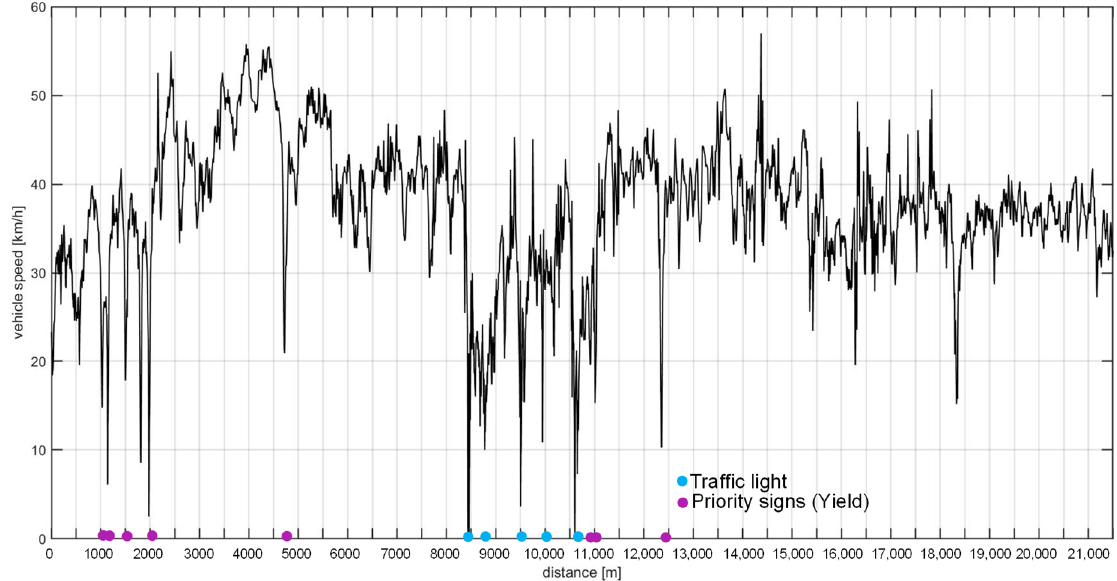
Figure 6. Recorded speed in a test vehicle.